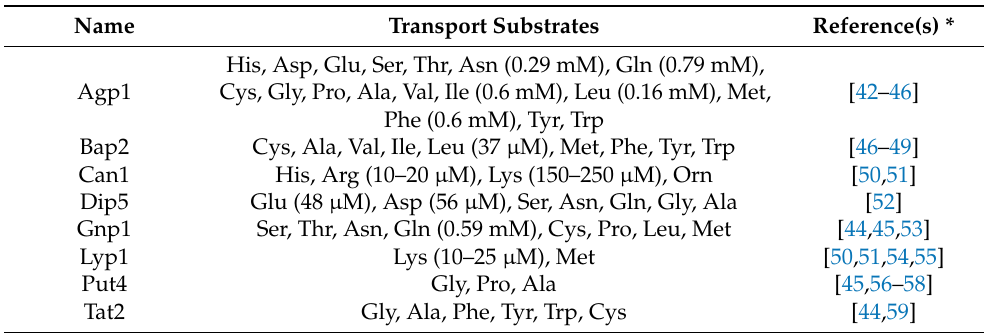
Table 1. Transporters used in this study and their reported substrates. Values in brackets indicate published Michaelis constants ( K m